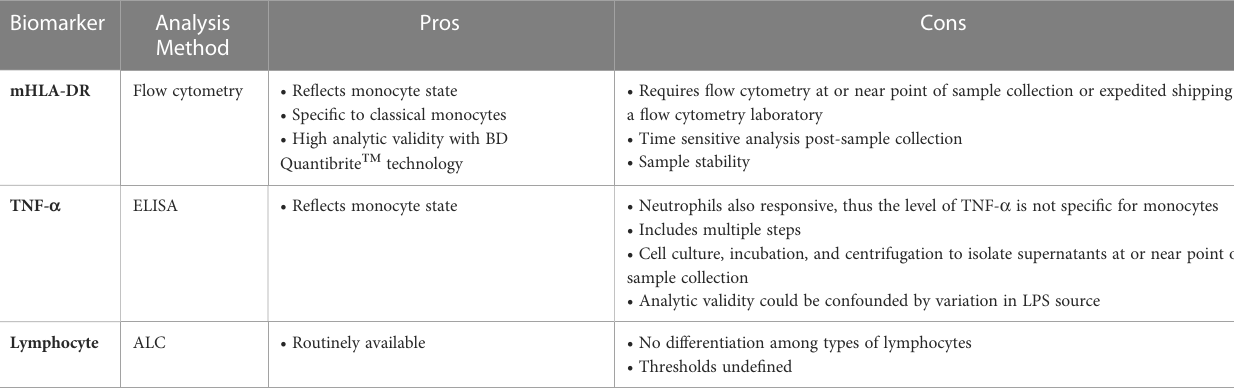
TABLE 2 Pros and cons of immune biomarkers for sepsis IP (4, 26, 27, 30, 35, 74, 130, 138, 139). Biomarker Analysis